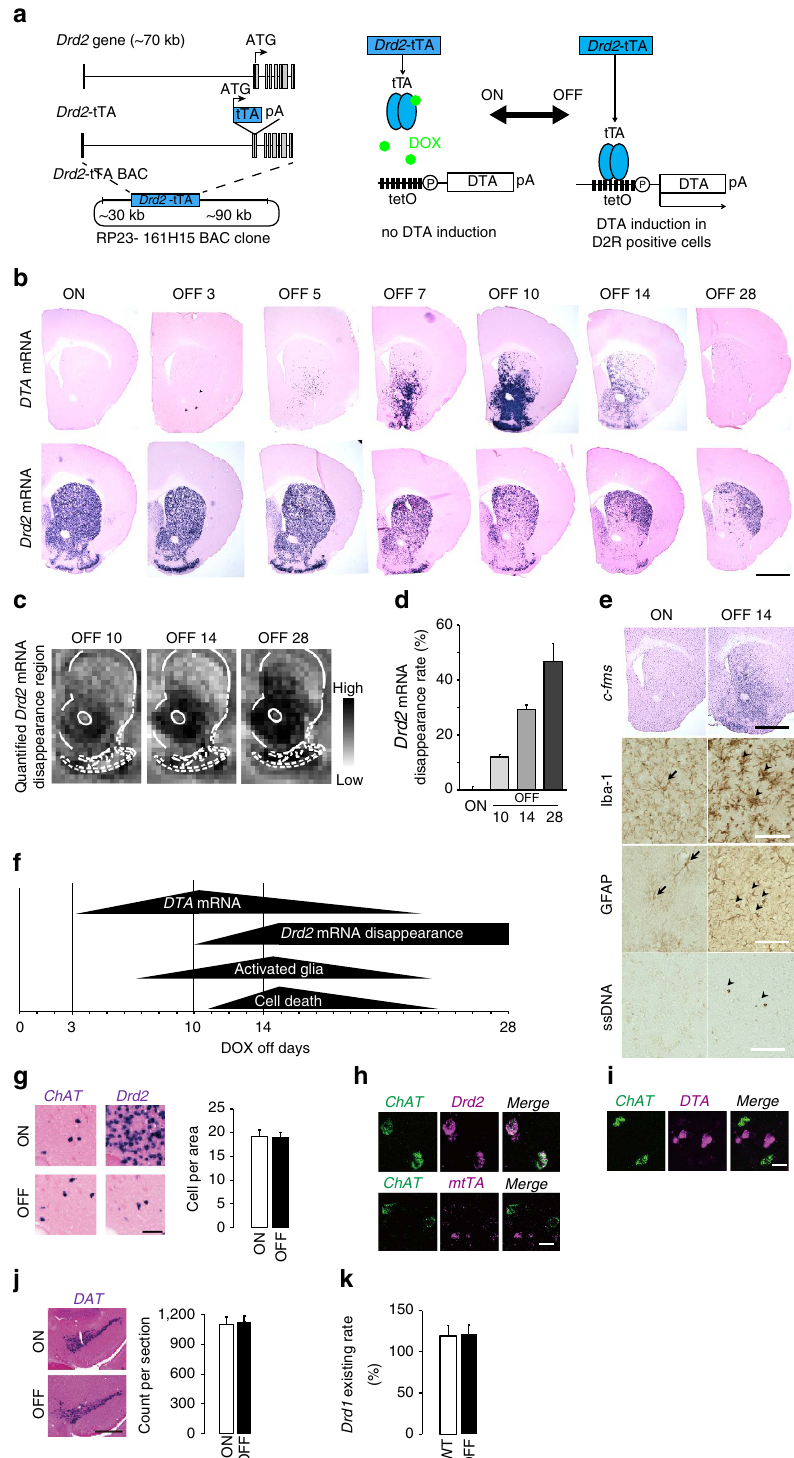
( n ¼ 3, viable, DTA-exposed D2-MSNs) and DOX-off day 20 ( n ¼ 4, ablated D2-MSNs) animals. The rates of triphasic patterns significantly decreased in both D2-DTA bigenic mice at DOX-off day 7 and 20 compared with those in controls. (DOX-on, 22.4%, 73 out of 326 versus DOX-off 7, 3.2%, 13 out of 404: P o 0.001, w 2 test; DOX-on versus DOX-off 20, 0.6%, 2 out of 314: P o 0.001, w 2 test). Rates containing inhibitory